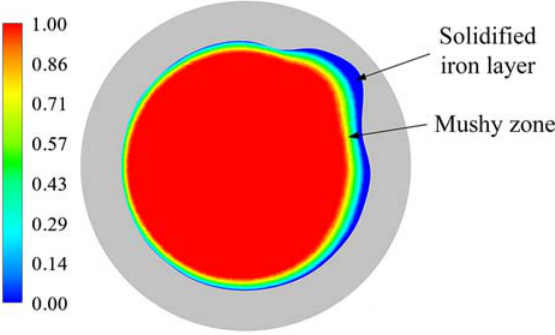
Figure 13. The volume fraction of hot iron on section D after 20% production reduction.